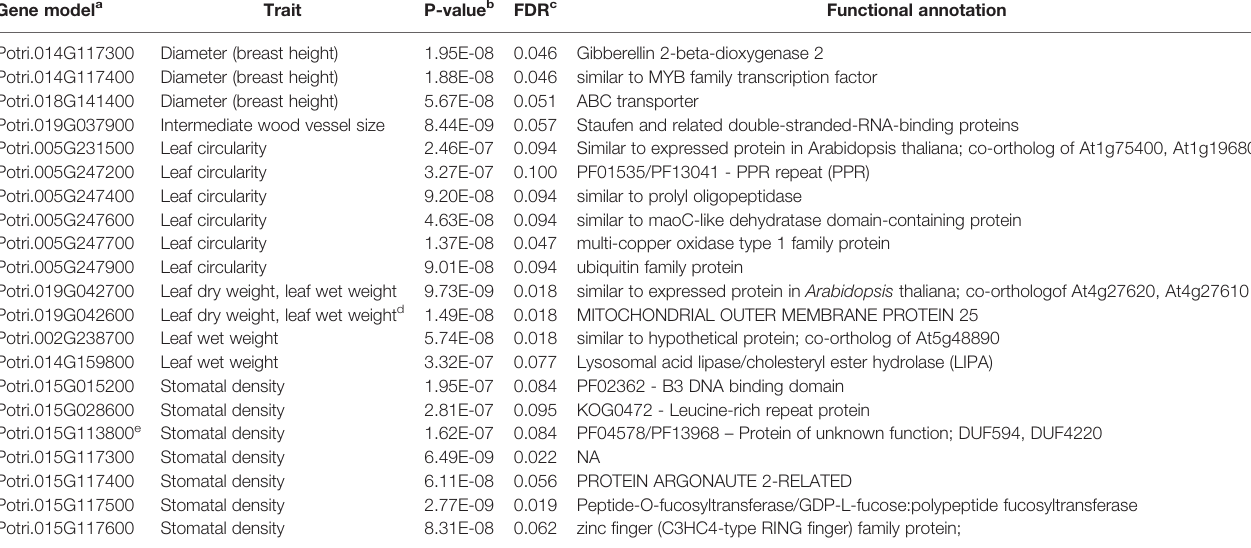
TABLE 3 | Genes identi fi ed from P. trichocarpa single trait